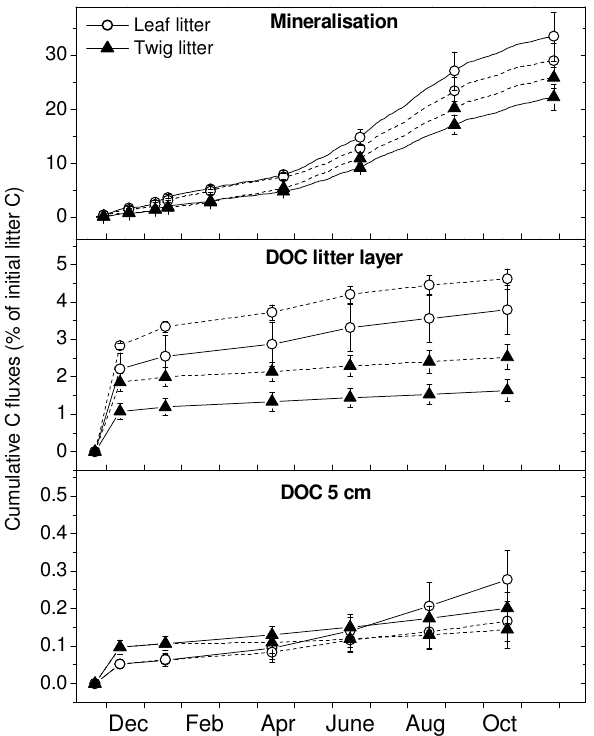
Fig. 5. Seasonal dynamics of litter-derived C respired as CO 2 , leached as DOC from the litter layer and recovered in the DOC at a depth of 5cm. The solid line represents the Rendzina and the dashed line the Cambisol. The values are the means of five replicates ± standard error.